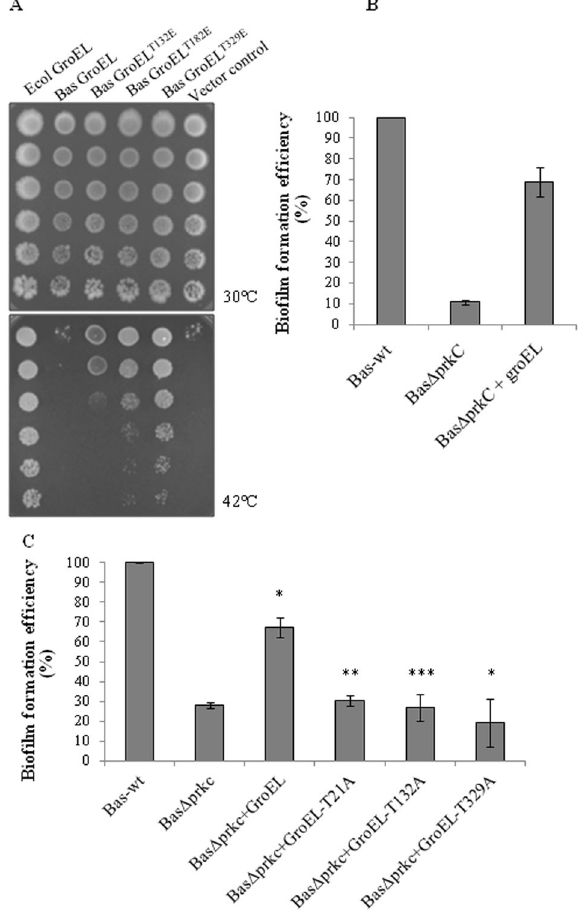
Fig. 7 Role of GroEL phosphorylation sites: a B. anthracis GroEL and GroES were expressed in E. coli SV2 temperature sensitive strain and spotting was performed. To assay the effect of GroEL phosphoryla- tion, speci fi c phospho-mimetic mutants were also expressed at 30 °C ( upper panel ) and 42 °C ( lower panel ). All the strains grew similarly at permissive temperature (30 °C) but not at 42 °C. As compared with native GroEL, cells expressing phospho-mimetic mutants were able to grow at 42 °C. The images show serially diluted cells from top to bottom in both the panels. b The bio fi lm formation ef fi ciencies of Bas -wt and Bas Δ prkC strains were compared with Bas Δ prkC cells overexpressing GroEL and calculated by crystal violet assay. As observed before (Fig. 1b), deletion of prkC led to loss of bio fi lm formation, which was recovered after overexpression of GroEL. Bio fi lm formation in Bas -wt was taken as 100% and relative ef fi ciency was calculated. The experiment was performed thrice and the error bars indicate the SE of three independent values. c The bio fi lm formation ef fi ciencies of Bas -wt and Bas Δ prkC strains were compared with Bas Δ prkC cells overexpressing either native GroEL or its phosphorylation site mutant (GroEL-T21A, GroEL-T132A, and GroEL-T329A), using crystal violet assay. The experiment was performed four times and the error bars show SE of four independent biological replicates. The p -value was calculated using two-tailed t -test, as shown by asterisk (* p < 0.05, ** p ≤ 0.005, *** p ≤